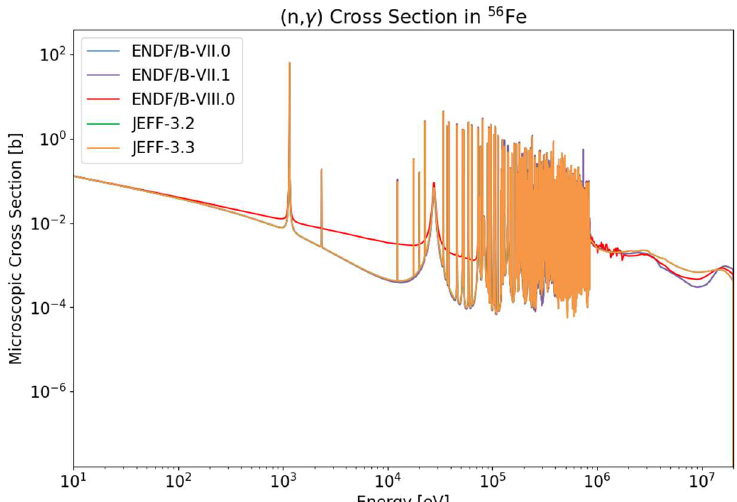
Figure 3. (n,γ) Capture Cross Section of 56 Fe for Considered Nuclear Data